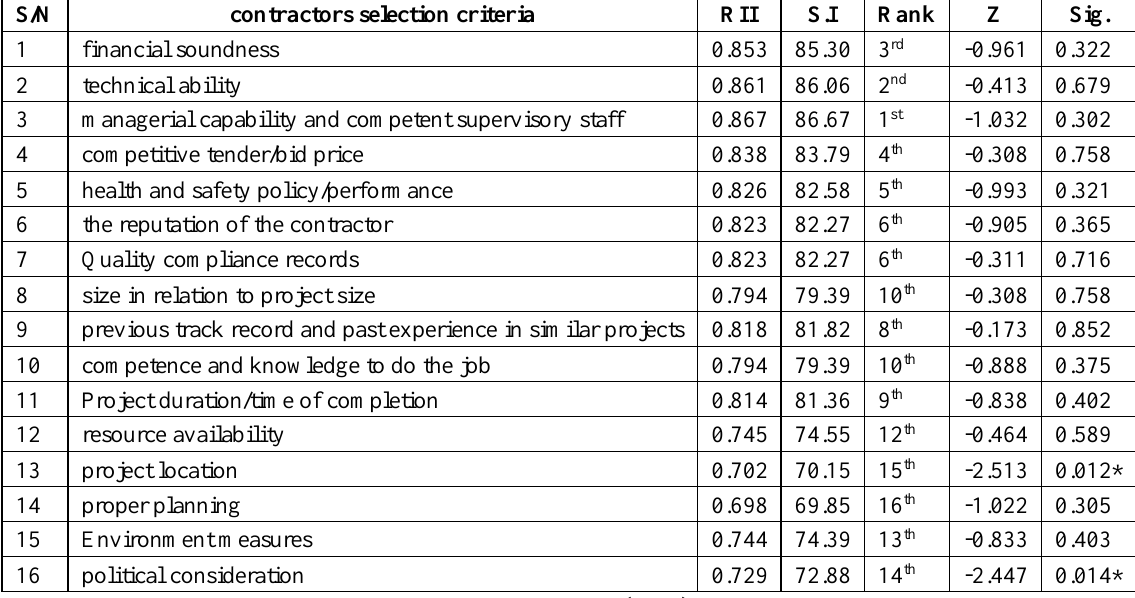
Table 5:Major contractors selection criteria on Civil engineering construction projects.